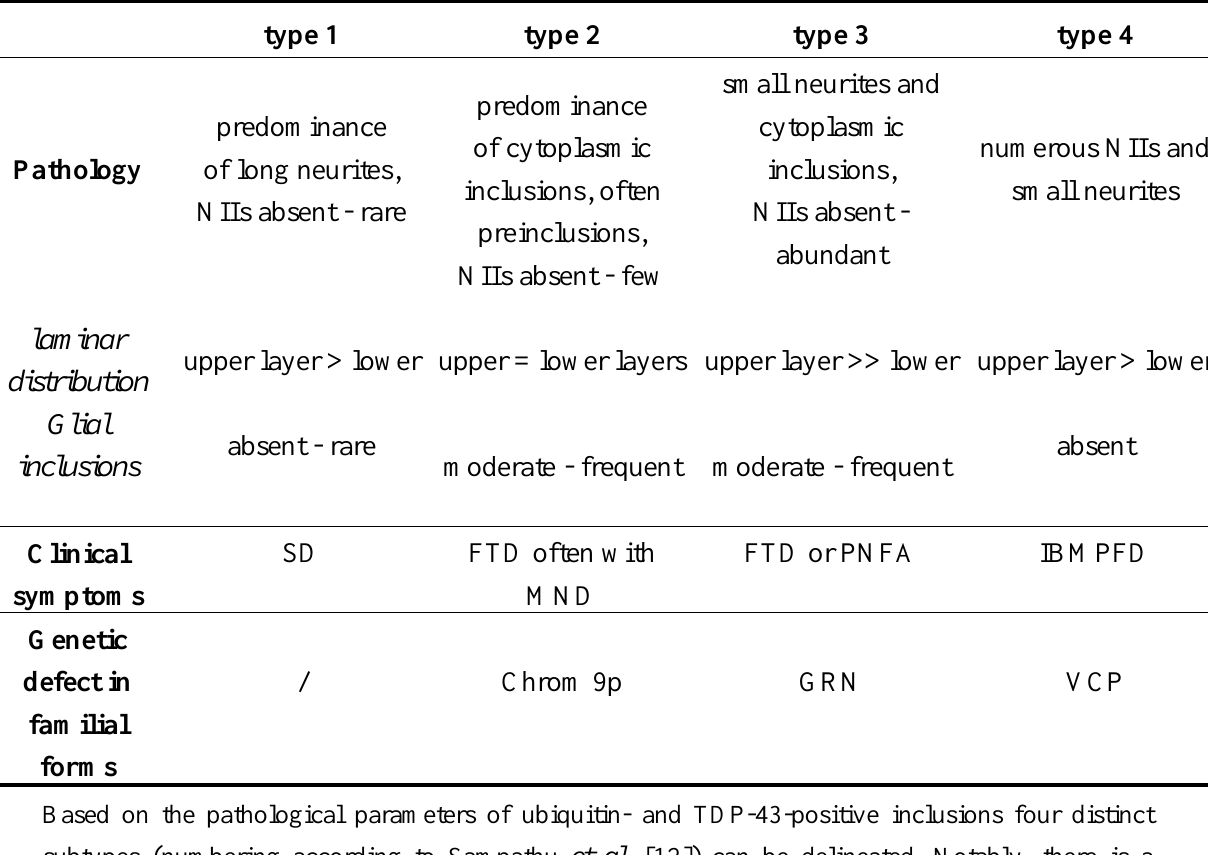
Immunohistochemistry with antibody against TDP-43 showing the characteristic cortical inclusions in the distinct FTLD-TDP subtypes (numbering according to Sampathu et al . [12]). Table 1. Heterogeneity among TDP-43-positive FTLD-U